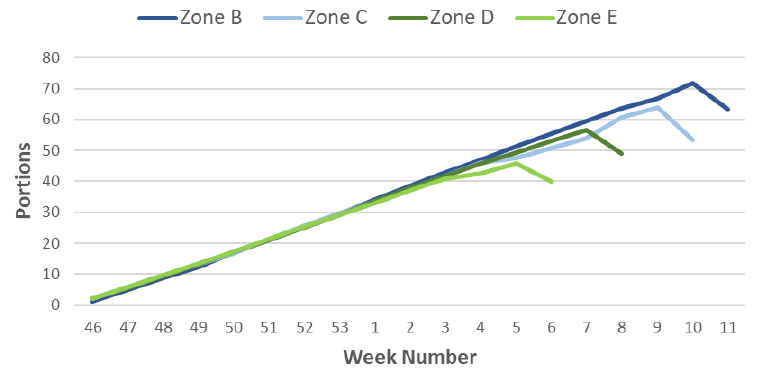
Figure 10. Representation of Portions in the most representative weeks for the climatic zones of the Murcia